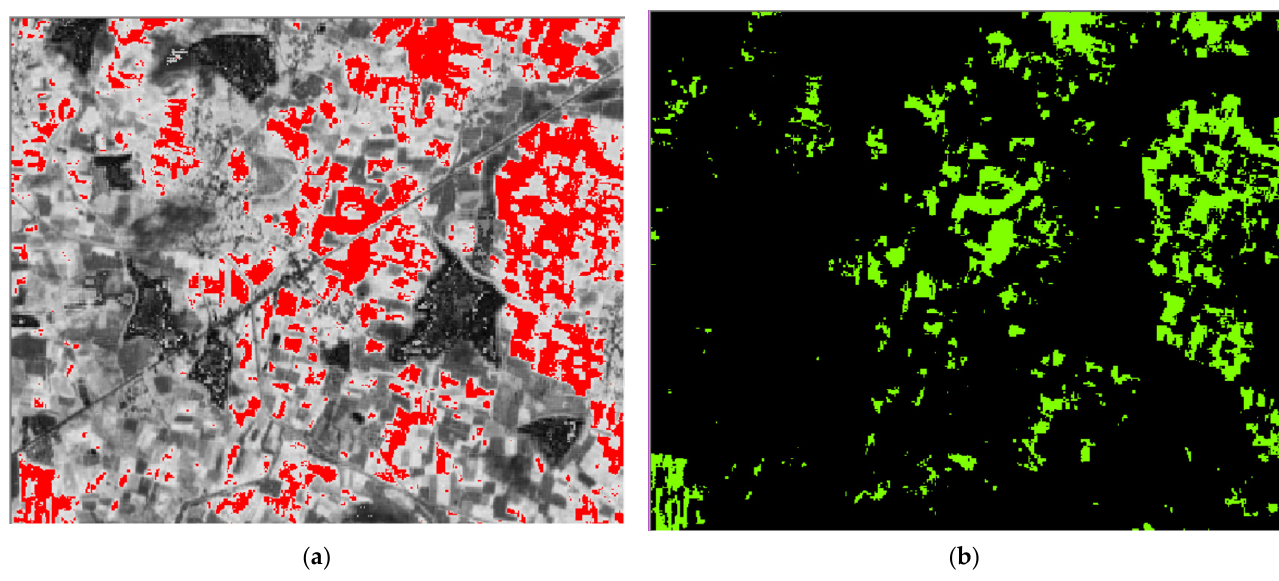
Figure 5. PCM Classification output with five samples signature file, ( a ) conventional mean PCM output ( b ) ISM based PCM output .